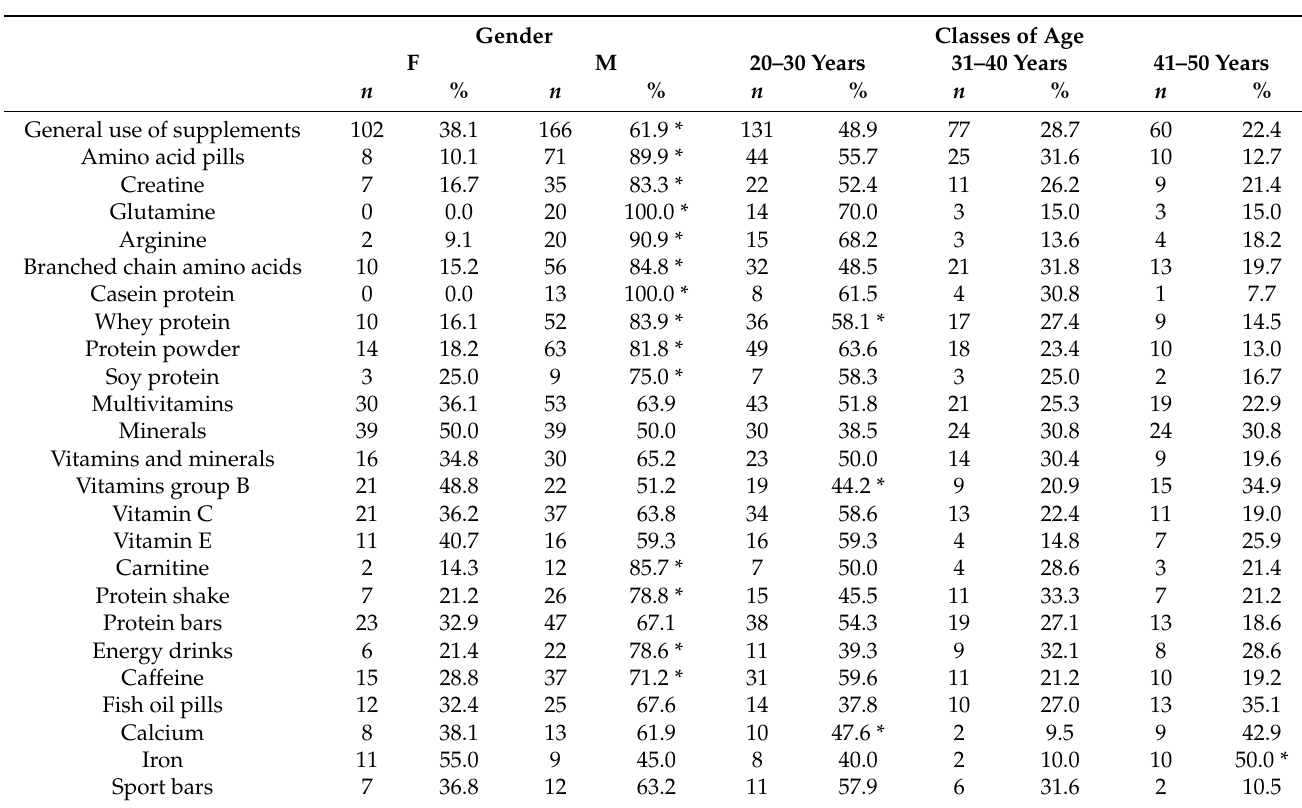
Table 3. Use of different types of food supplements by sample characteristics.